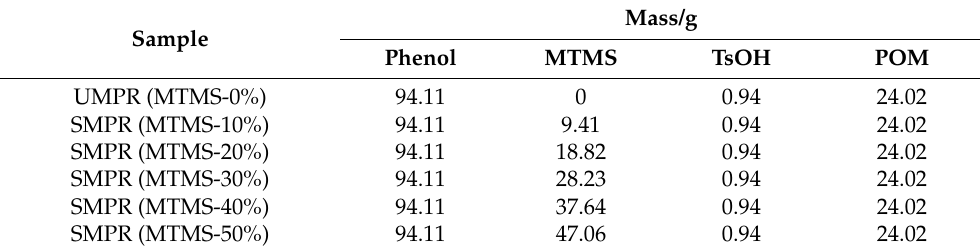
Table 1. Specific formulas of SMPR with different MTMS content *.